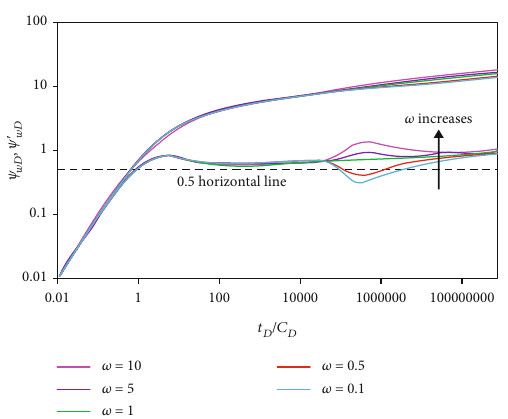
Figure 18: Well test curves of the pressure drawdown well test under di ff erent storage